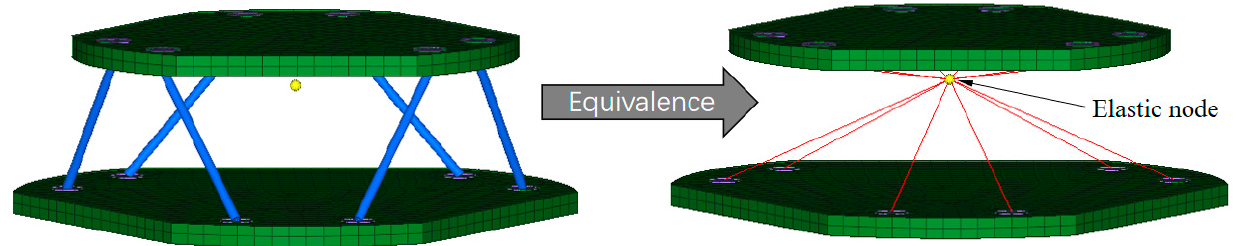
Figure 6. Schematic diagram of SVIS equivalent to elastic nodes in FEM.